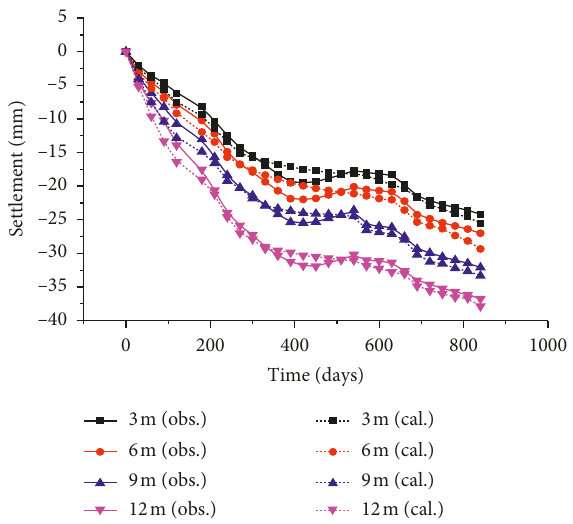
Figure 8: Comparison between observed and calculated settle- ments after Table 2: Creep parameters of every layer. E R Fill stratum T r H